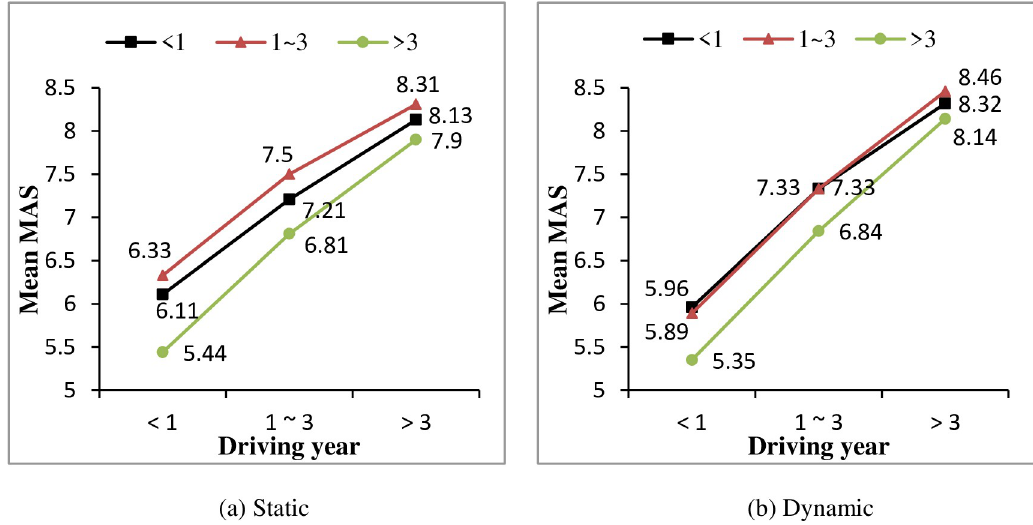
Fig 6. Effect of driving year on mutual-assessment scores (MAS) under different driving year conditions.